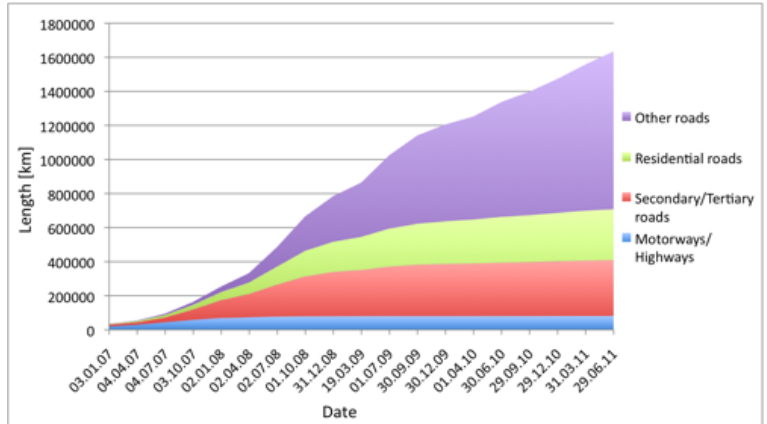
Figure 4. Development of OSM Street Network in Germany by Street Category (2007–2011).